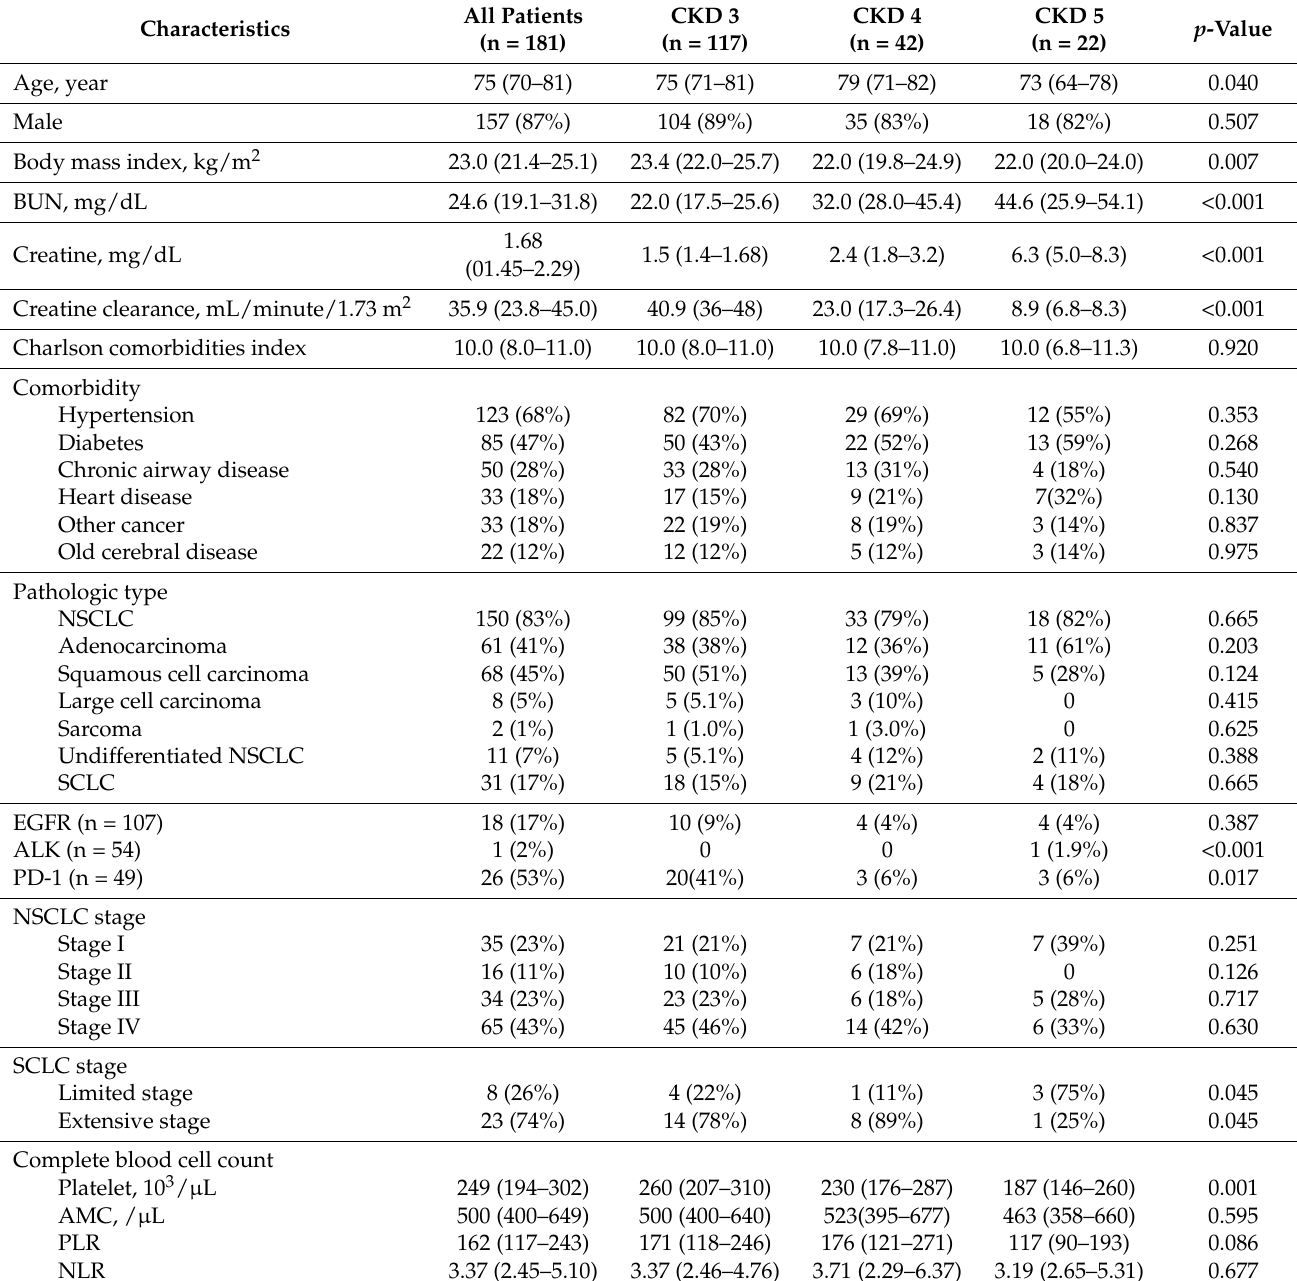
Table 1. Clinical characteristics and treatment of lung cancer patients with chronic kidney